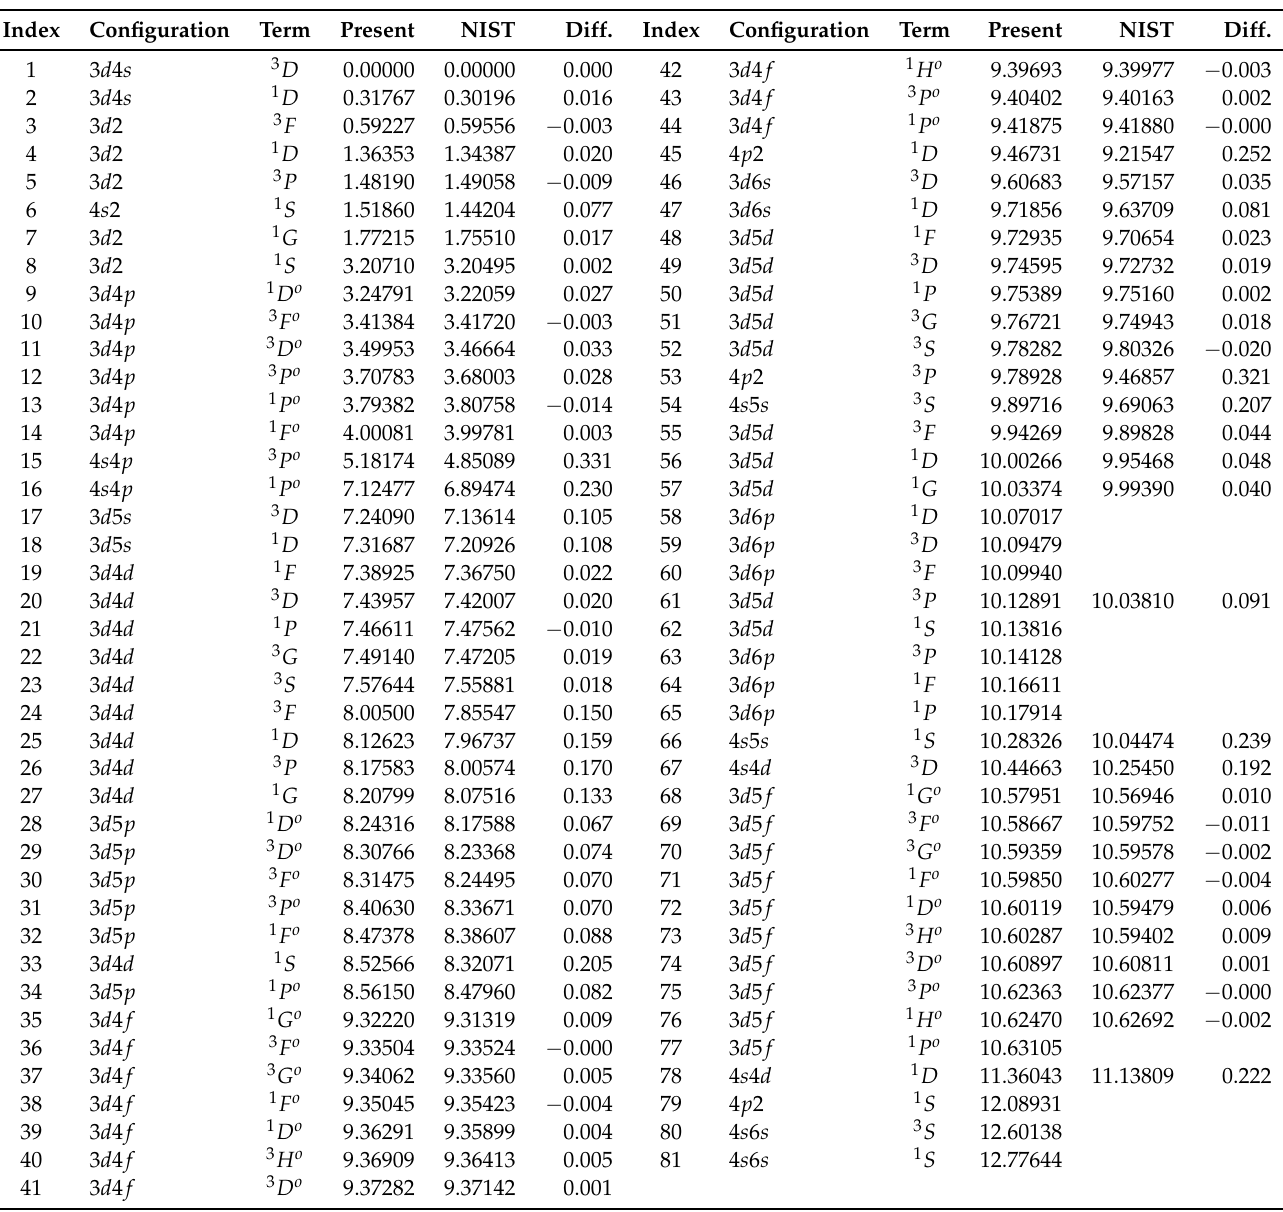
Table 2. The Sc II target state excitation energies (in